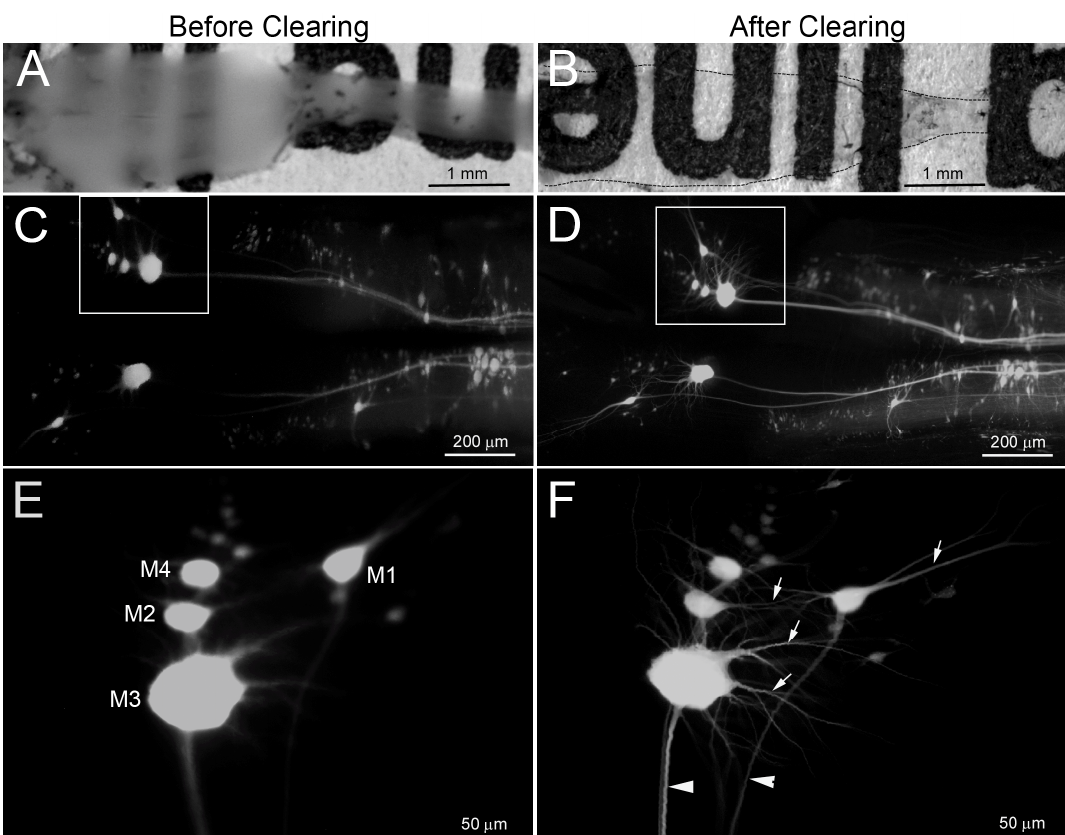
Figure 2. BABB clearing increases the resolution of epifluorescence imaging of RS neurons in brain wholemounts. The SC was transected at the level of the 5th gill and 6 weeks later, surviving RS neurons were labeled retrogradely by application of DTMR to a second TX located at the level of the 2nd gill, 5 mm rostral to the original TX. After allowing one additional week for dye transport, the brainstems were imaged by epifluorescence. ( A , C , E ) before BABB clearing. ( B , D , F ) after BABB clearing. ( A ) brightfield image of a lamprey brainstem and SC, which were fixed, washed, placed on a sheet with printed black letters, and photographed with a CCD camera through a stereomicroscope (Olympus, SZX12). Rostral is on the left. ( B ) the same sample is much more transparent after BABB clearing. The specimen is outlined by the dotted line. ( C – F ) images captured by a widefield fluorescence microscope (Nikon, 80i) with 4x objective before ( C ) and after ( D ) BABB clearing. ( E , F ) images from the boxed areas in ( C ) and ( D ) enlarged and rotated 90°, so that rostral is now up. The images contain the swollen perikaryal of the identified mesencephalic RS neurons M 1–4 (note, in unlesioned animals, M 4 is ordinarily much smaller than M 1–3 —see Figure 4A). Arrows in ( F ) point to dendrites of the M cells; arrowheads indicate descending axons.